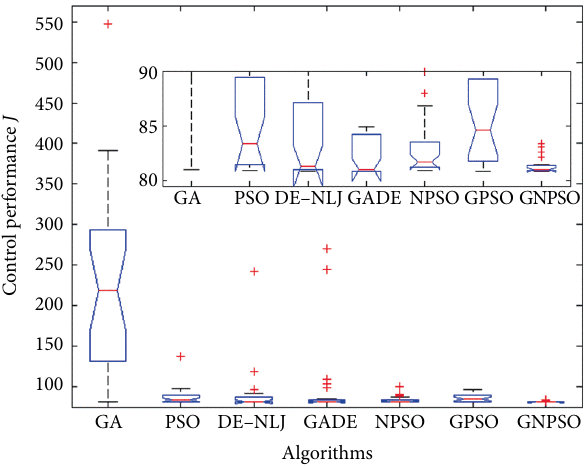
Figure 3: ANOVA tests of the control performance obtained by different algorithms for linear wing vibration system. system.Table 3: Ranks, statistics and related p -values achieved by the Friedman, Friedman aligned, and Quade tests for control perfor- mance of linear wing vibration control system obtained by different algorithms.